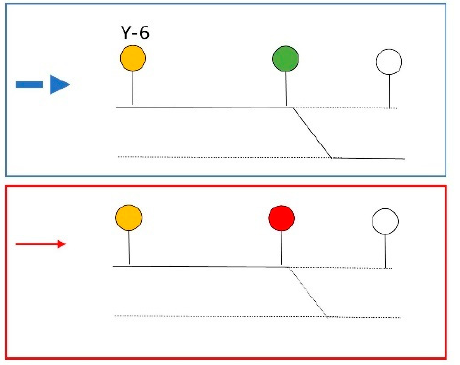
Figure 5. There can be variation in the signal aspect at a specific location. In the top approach, the first signal has aspect yellow:6 (Y-6) because the switch after the next signal has a maximum per- mitted speed of 60 km/h. In the bottom approach, the first signal is yellow because the next signal is